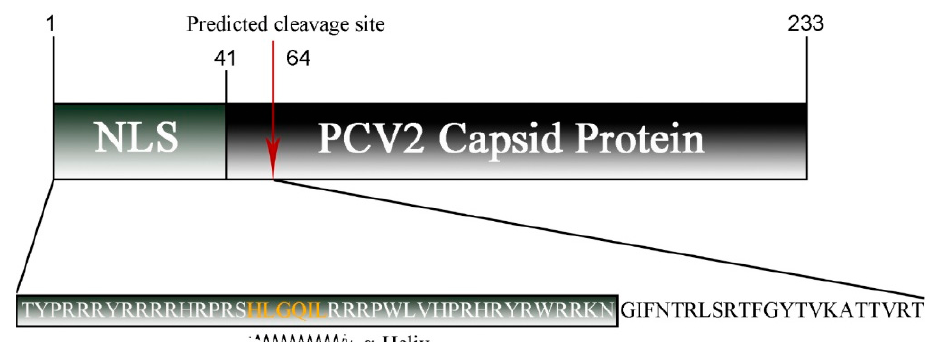
Figure 1. Schematic diagram of the PCV2 capsid protein sequence with the NLS region and predicted cleavage site (red arrow) indicated. The sequence of the predicted MLS used in this study is shown below, where an α -helix is marked in orange.